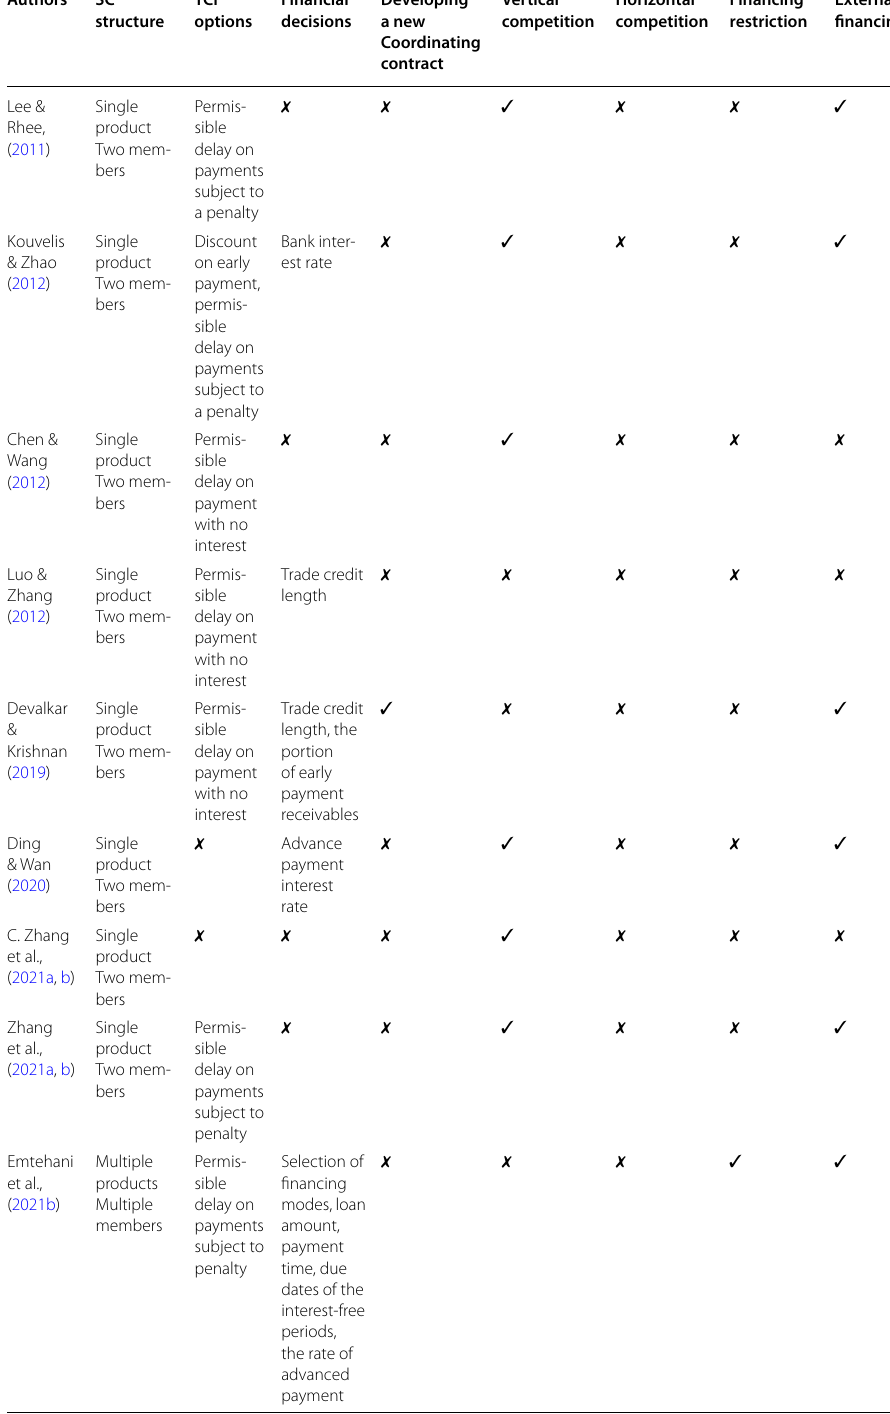
Table 1 A comparison between the most related previous studies and the current work Authors SC